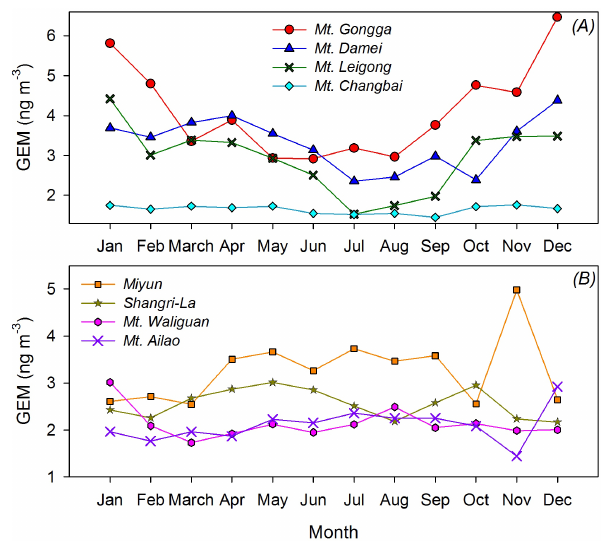
Figure 5. Monthly variations of GEM concentrations at remote sites of